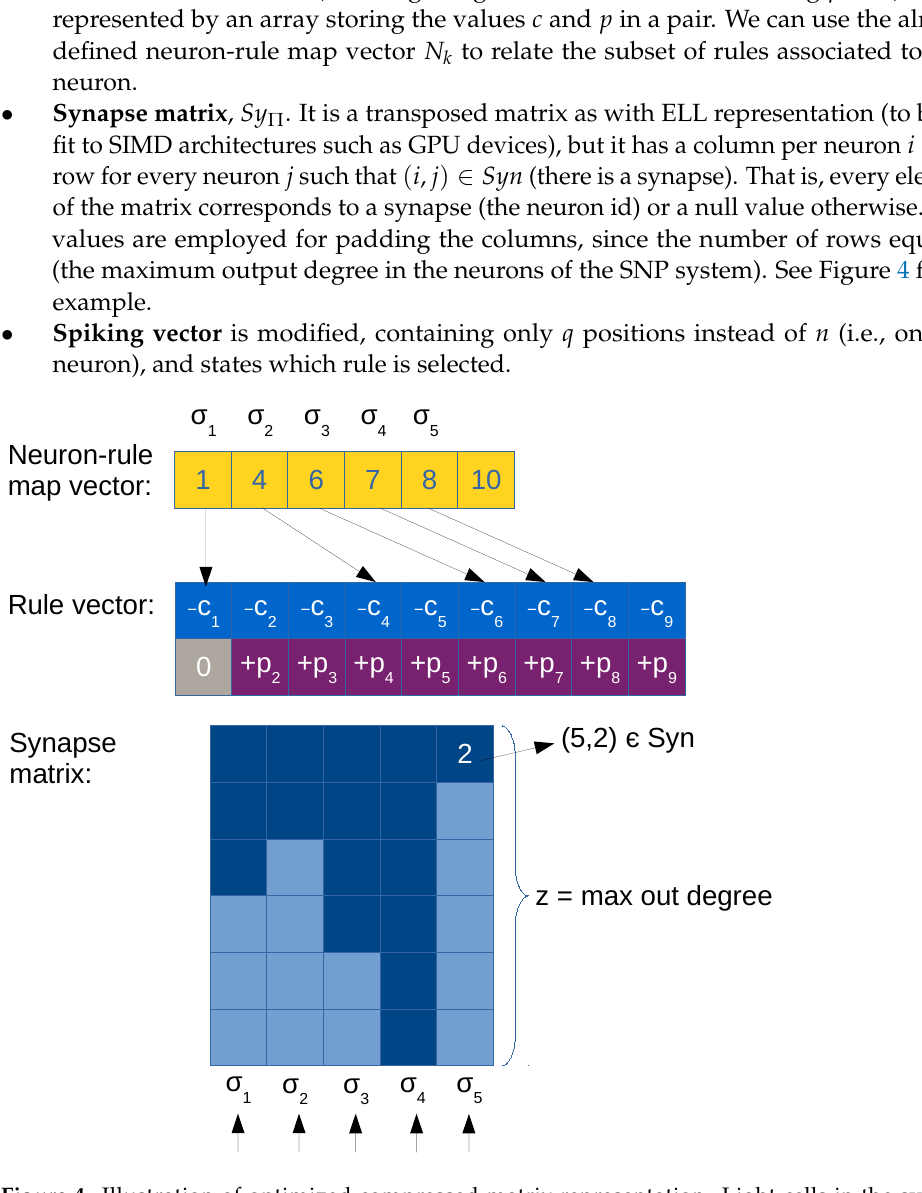
Figure 4. Illustration of optimized compressed matrix representation. Light cells in the synapse matrix are empty values (0), dark cells are positions with values greater than 0 (i.e., with neuron labels). The rows below illustrate threads, showing the level of parallelism that can be achieved (each column/neuron in parallel). The first column in the rule vector is a forgetting rule, where p =